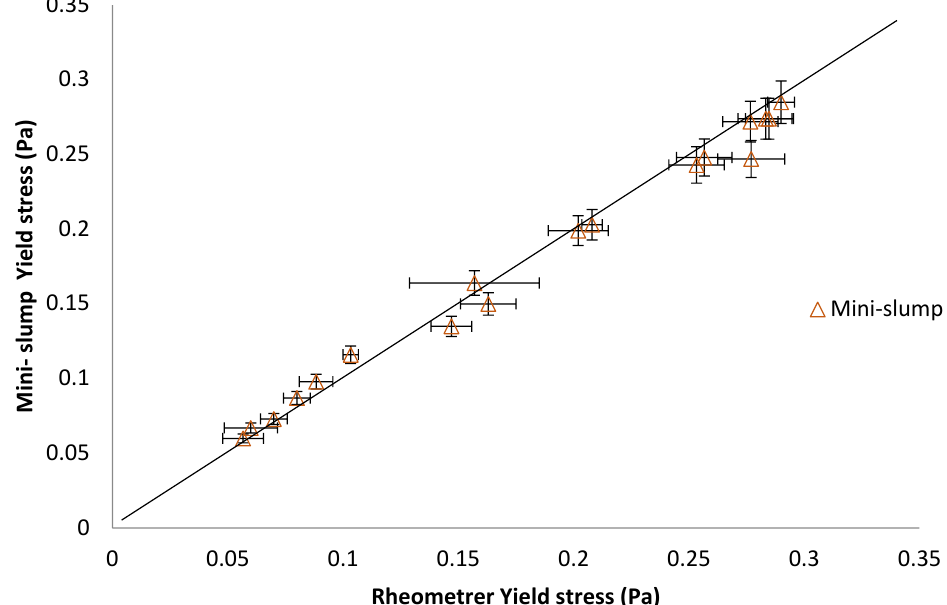
Figure 3. Correlation between the yield stresses determined using a mini-slump test and rheometer with the blended SP at optimum dosage with different proportions of SP-A and SP-B, for Cement 1, Cement 2 and Cement 3.